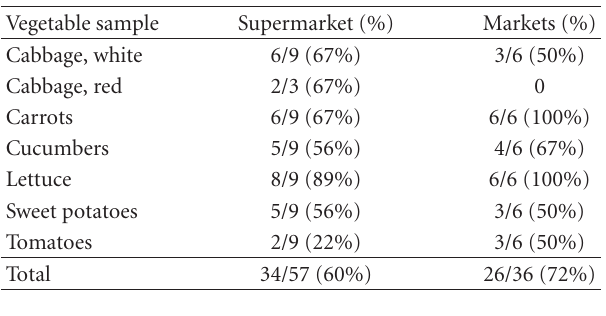
Table 1: Level of contamination by Pseudomonas aeruginosa of vegetable samples from nine supermarkets and six markets investigated in this study.